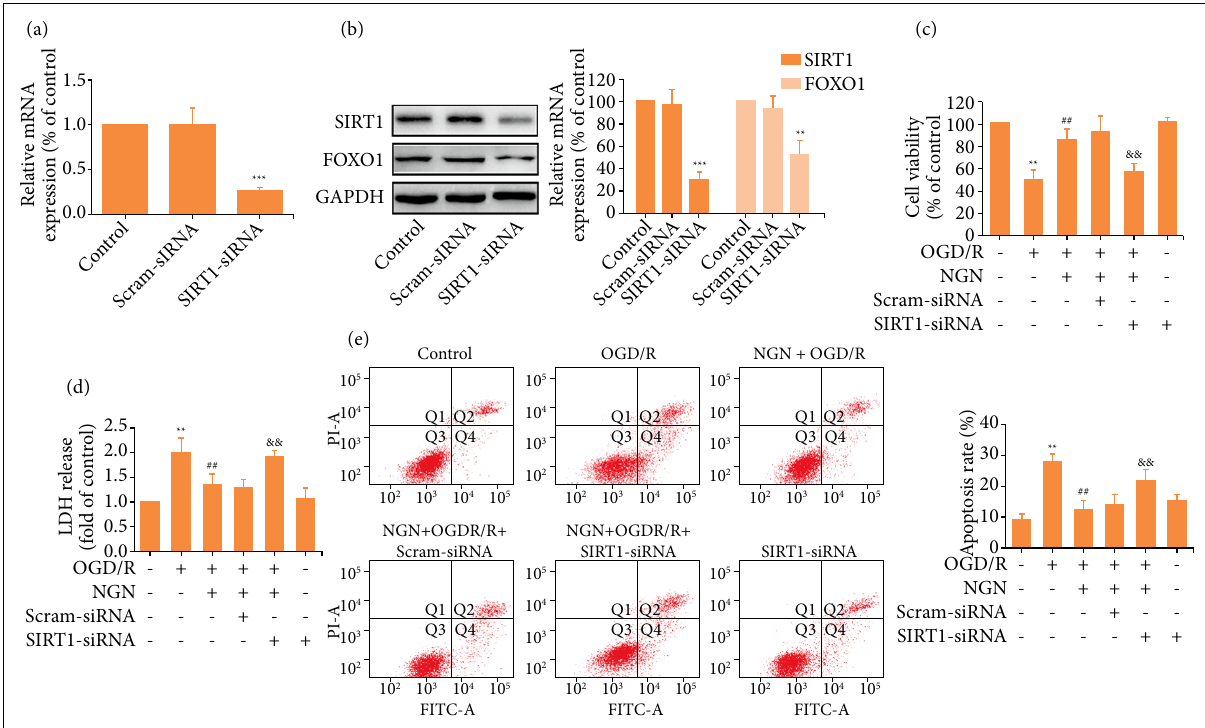
Figure 4 – Effects of SIRT1-siRNA transfection on the protection of naringenin against OGD/R injury in HT22 cells. After transfection with SIRT1-siRNA (50 nmol·L –1 ) or scrambled siRNA (Scram-siRNA; 50 nmol·L –1 ) for 48 h, (a) the level of SRT1 mRNA was measured by Quantitative RT-PCR and (b) the expressions of SIRT1 and FOXO1 proteins were detected by western blot analysis. Data were expressed as mean ± SD from 3-4 independent experiments. ** P < 0.01, *** P < 0.001 vs. Scram-siRNA group. HT22 cells were transfected with SIRT1-siRNA (50 nmol·L –1 ) or Scram-siRNA (50 nmol·L –1 ) for 6 h and then treated with naringenin (80 μ mol·L –1 ) for 2 h followed by treatment with OGD (6 h)/R (24 h); (c) Cell viability was detected by CCK-8 assay and (d) LDH releases were assayed by LDH cytotoxicity assay kit; (e) The apoptosis rate was detected by Annexin V-FITC/PI double staining followed by flow cytometry. Data were expressed as mean ± SD from 3-4 independent experiments. ** P < 0.01 vs. control group; ## P < 0.01 vs. OGD/R group; && P < 0.01 vs. NGN + OGD/R + Scram-siRNA group. NGN: naringenin; OGD/R: oxygen-glucose